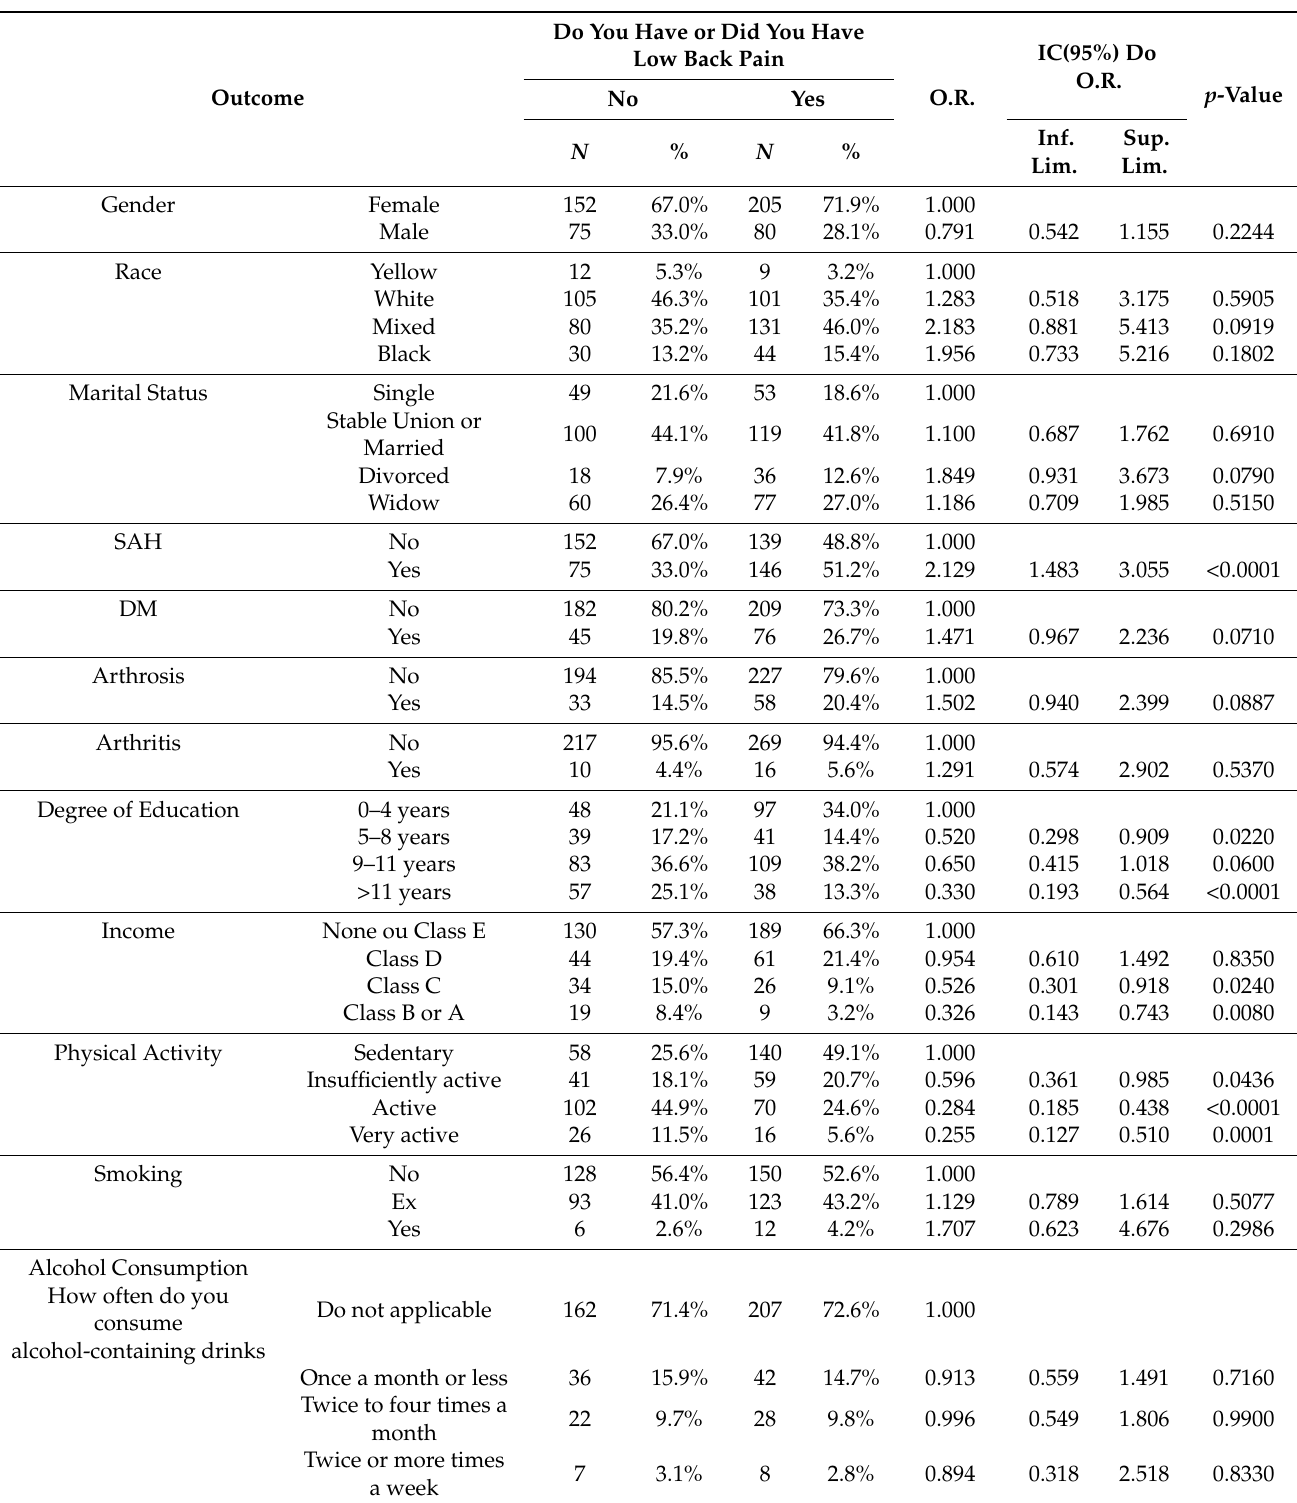
Table 1. Characteristics of the elderly population in the metropolitan region of Bel é m, PA. Do You Have or Did You Have Low Back Pain Outcome